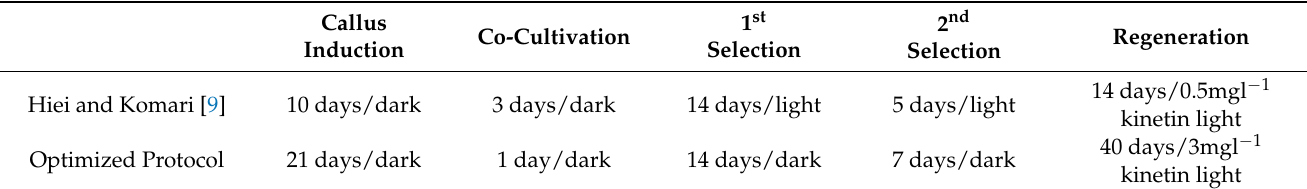
Table 1. Modifications of the optimized steps in comparison with the previously published protocol.